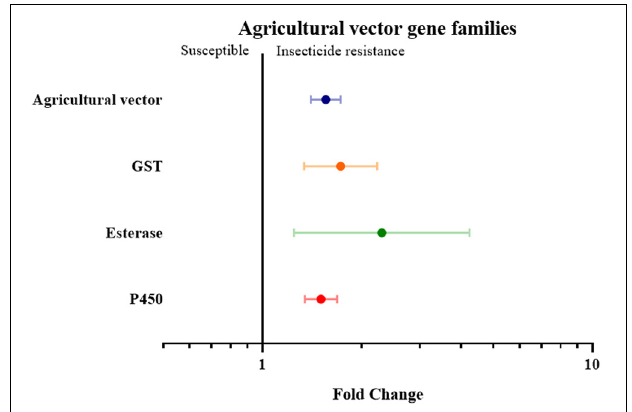
FIGURE 7 | Meta-analytical, sub-group estimate of the gene expression related to insecticide resistance, with 95% CI in the agricultural vector with different gene families and the P450 gene clade. The overall effect represents the collective effect of each insecticide class in all the relevant